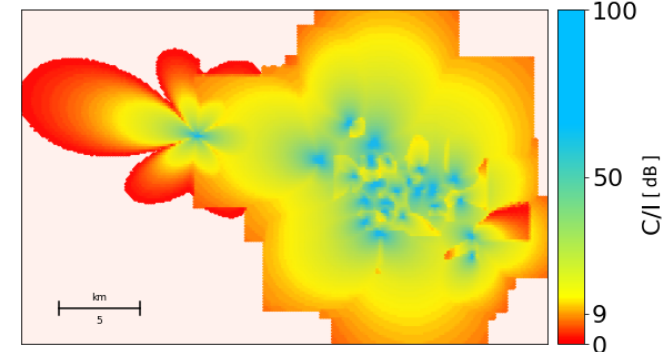
Figure 17. Carrier to interference ratio in the city after